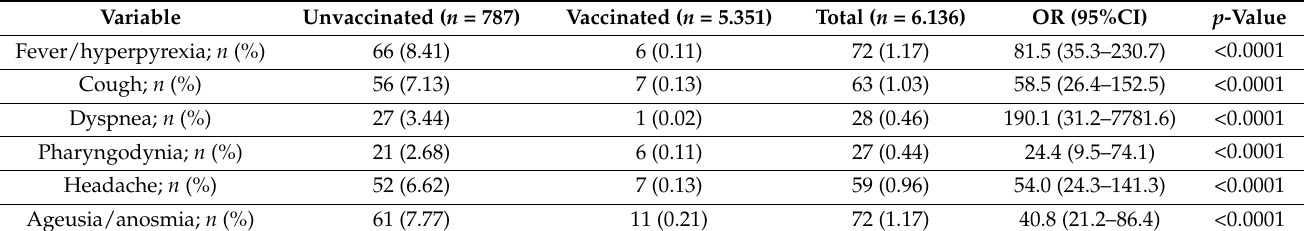
Table 2. Characteristics of recorded symptoms, per group (vaccinated and unvaccinated HCWs).